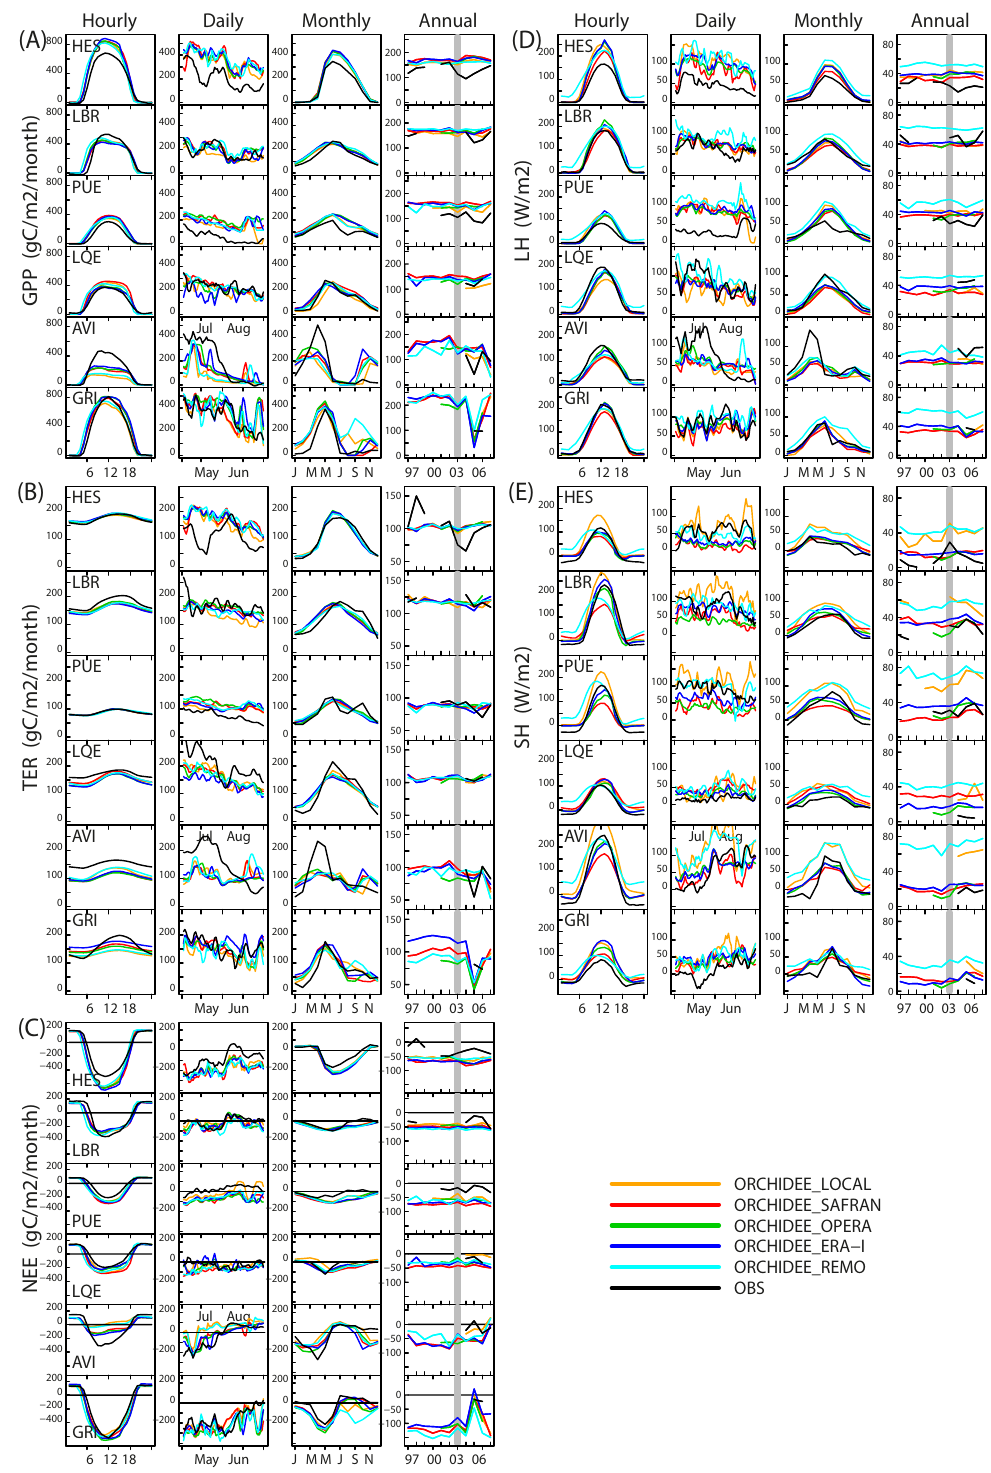
Fig. 5. Simulated and measured carbon fluxes (gCm − 2 month − 1 ) and water fluxes (Wm − 2 ) . (a) : GPP; (b) : TER; (c) : NEE; (d) : LH and (e) : SH. Hourly mean diurnal cycle over peak growing season corresponds to 2004–2007; daily mean with a running mean of 3 days for PGS of 2003 at HES, LBR and PUE, of 2005 for LQE, AVI and GRI; monthly mean seasonal cycle over 2004–2007, except for AVI at 2005 and for GRI at 2006 when winter wheat was